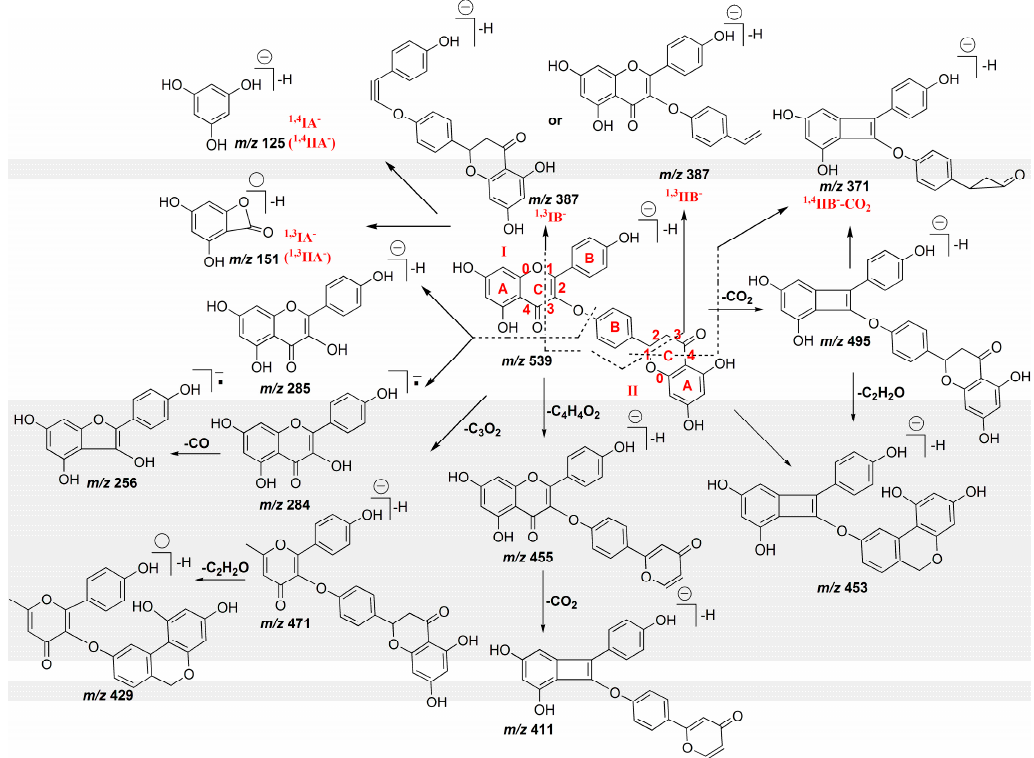
Figure 4. Proposed fragmentation pathway of chrysocauloflavone I in ( − )ESI mode.